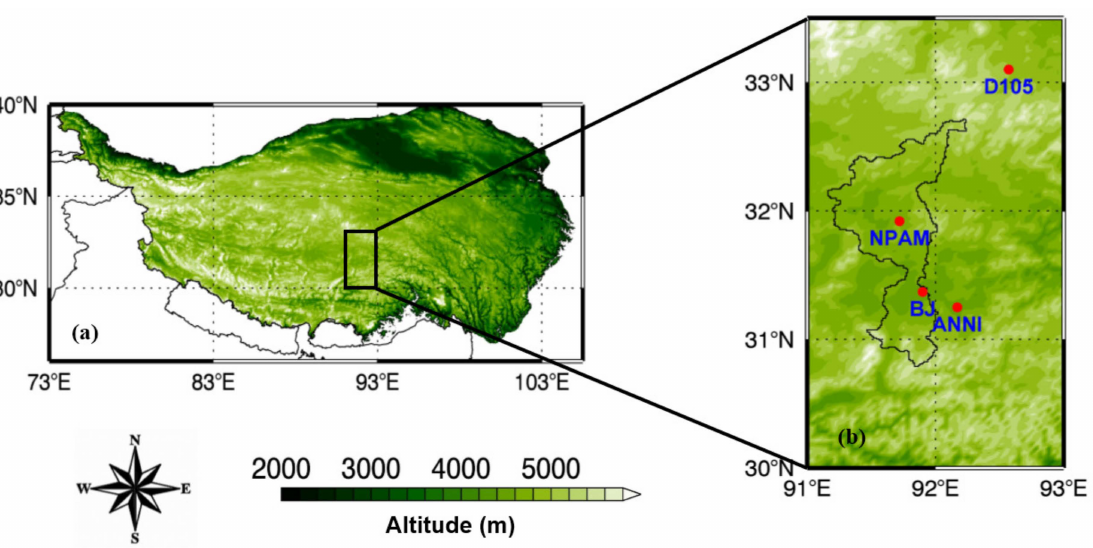
Figure 1. Location and topography of the study area. ( a ) Location of the TP and Coordinated Enhanced Observing Period Asia–Australia Monsoon Project on the TP (CAMP / Tibet) experiment area. ( b ) Location of the meteorological stations (red points) and the Nagqu river basin (curved boundary) in the CAMP / Tibet experiment